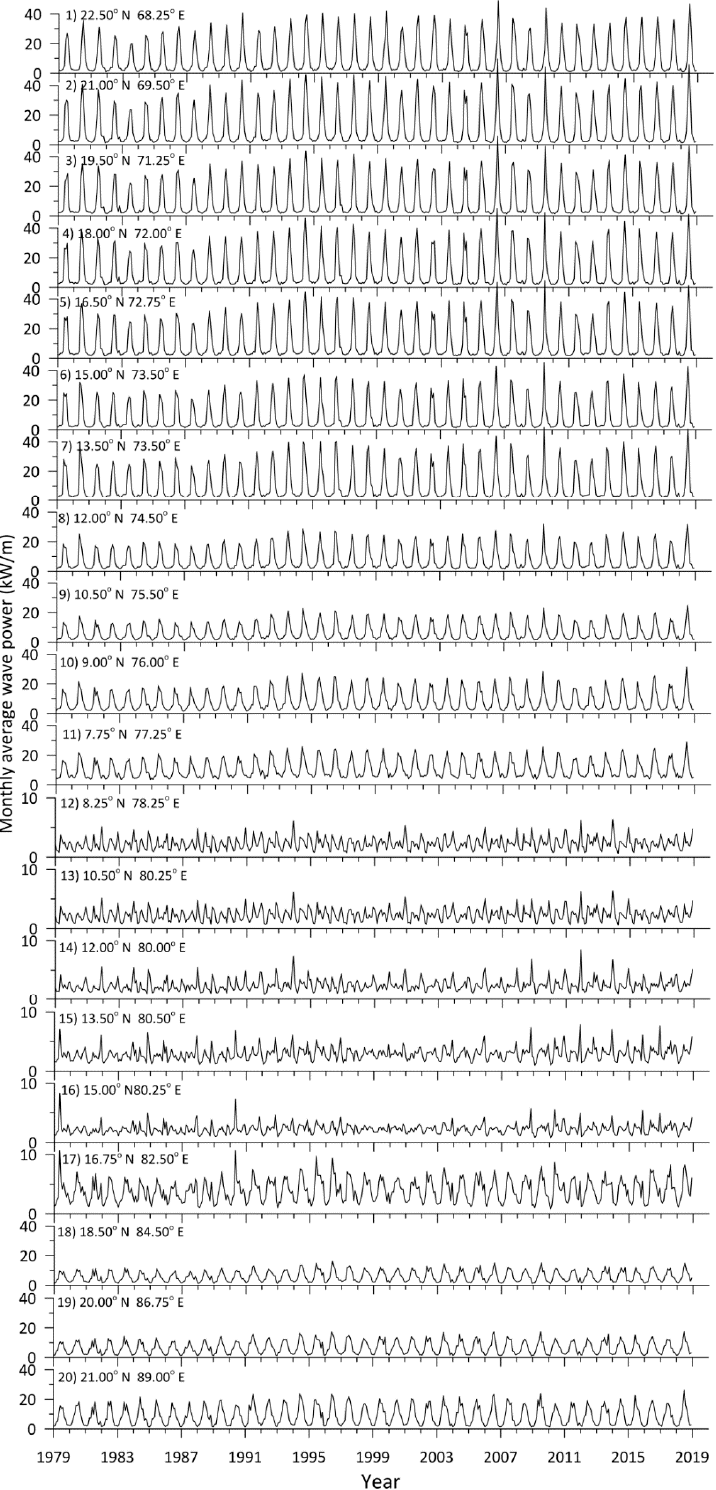
Figure 4. Time series plots of monthly average wave power from 1979 to 2018 at the 20 locations in Indian shelf seas.